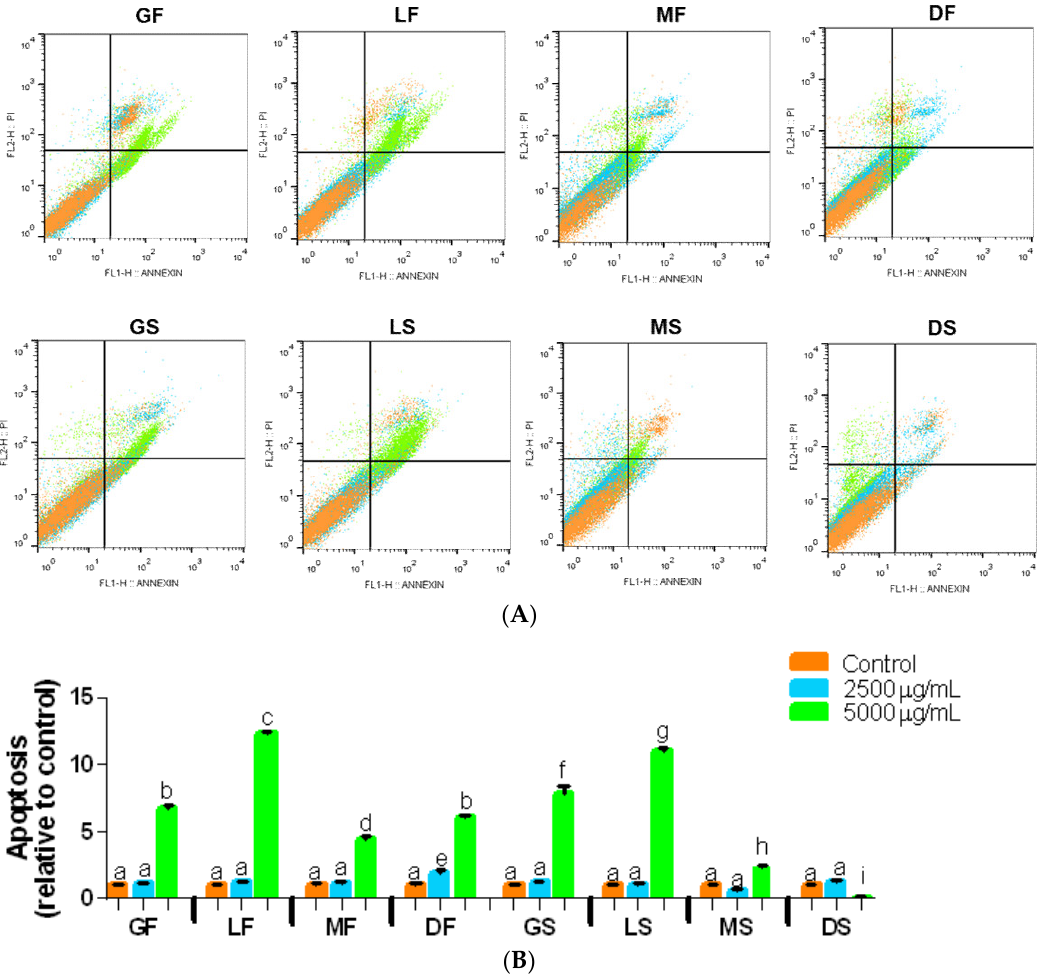
Figure 4. Effect of coffee extracts on rate of apoptosis in DU-145 cells after 24 h after incubation. Flow cytometry analysis of coffee extracts are illustrated in ( A ). ( B ) Relative increase rate of apoptotic cells of DU-145 treated with freeze-dried and spray-dried coffee extracts after 24 h of treatment. Relative comparison between untreated cells (CT) and cells incubated with coffee extracts. Means significant